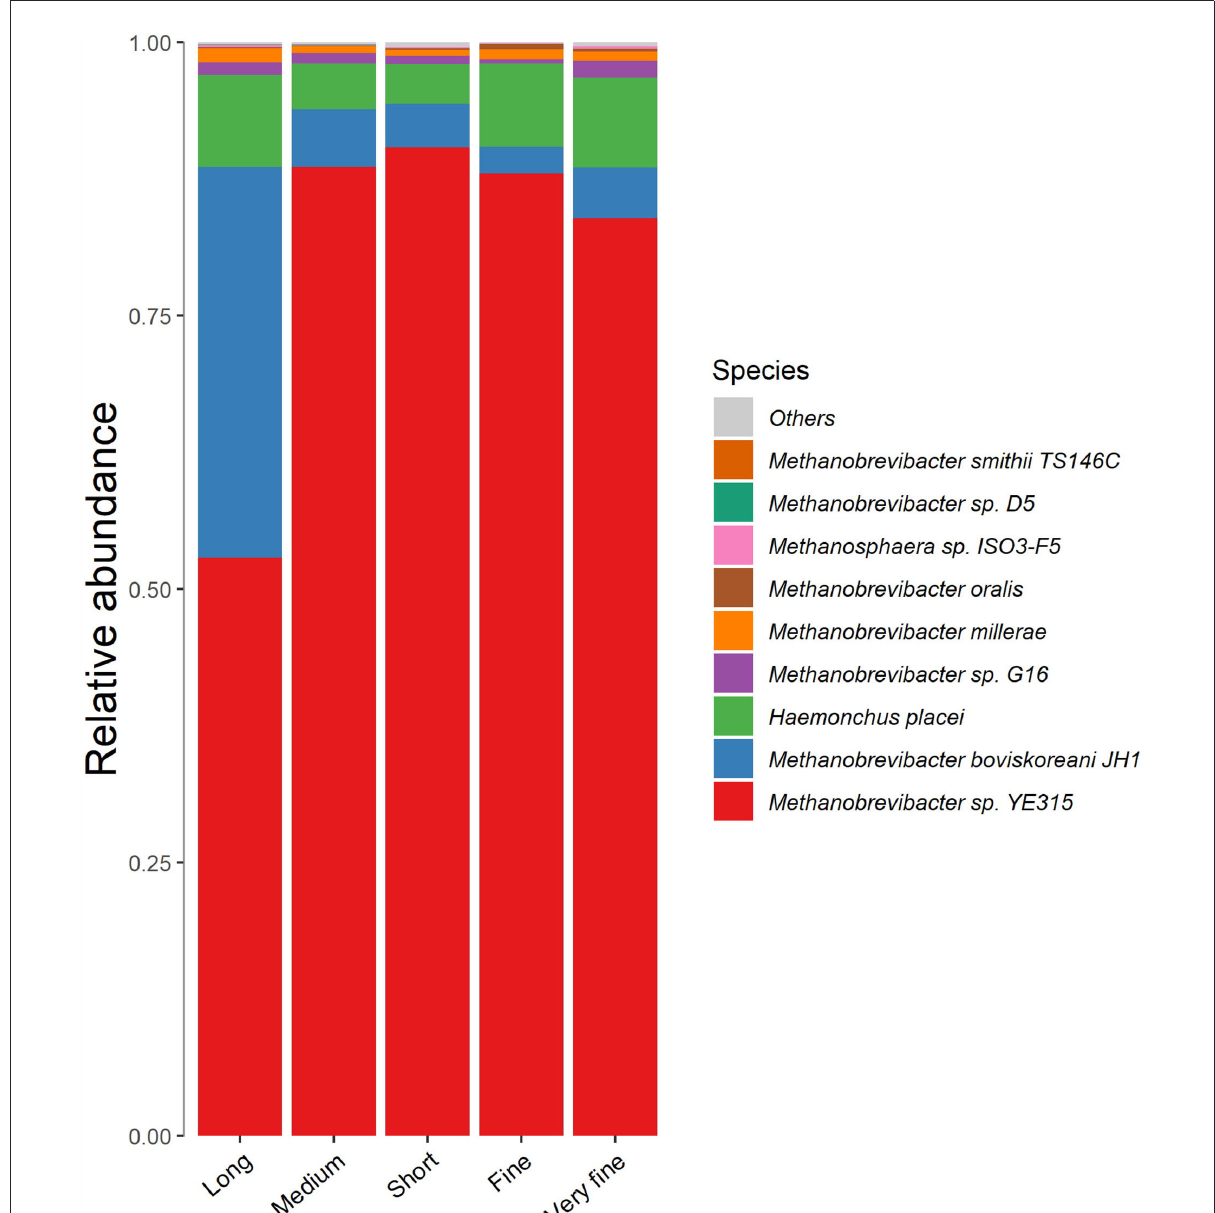
FIGURE4 The cluster histogram of methanogen at species level. Long: 32.97% peNDF > 1.18 treatment; Medium: 29.93% peNDF > 1.18 treatment; Short: 28.14% peNDF > 1.18 treatment; Fine: 26.48% peNDF > 1.18 treatment; Very fine: 24.75% peNDF > 1.18